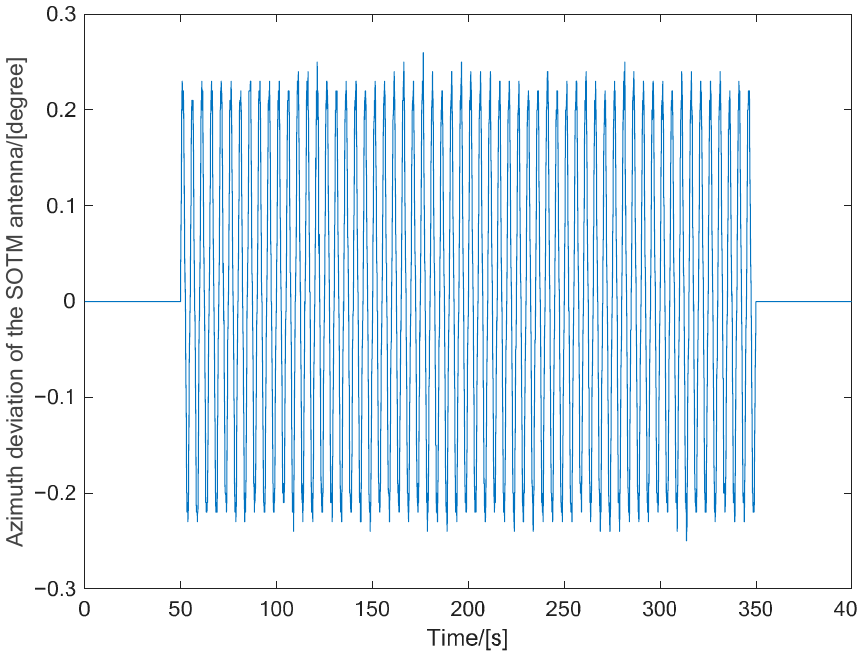
Figure 9. Converted azimuth deviation.